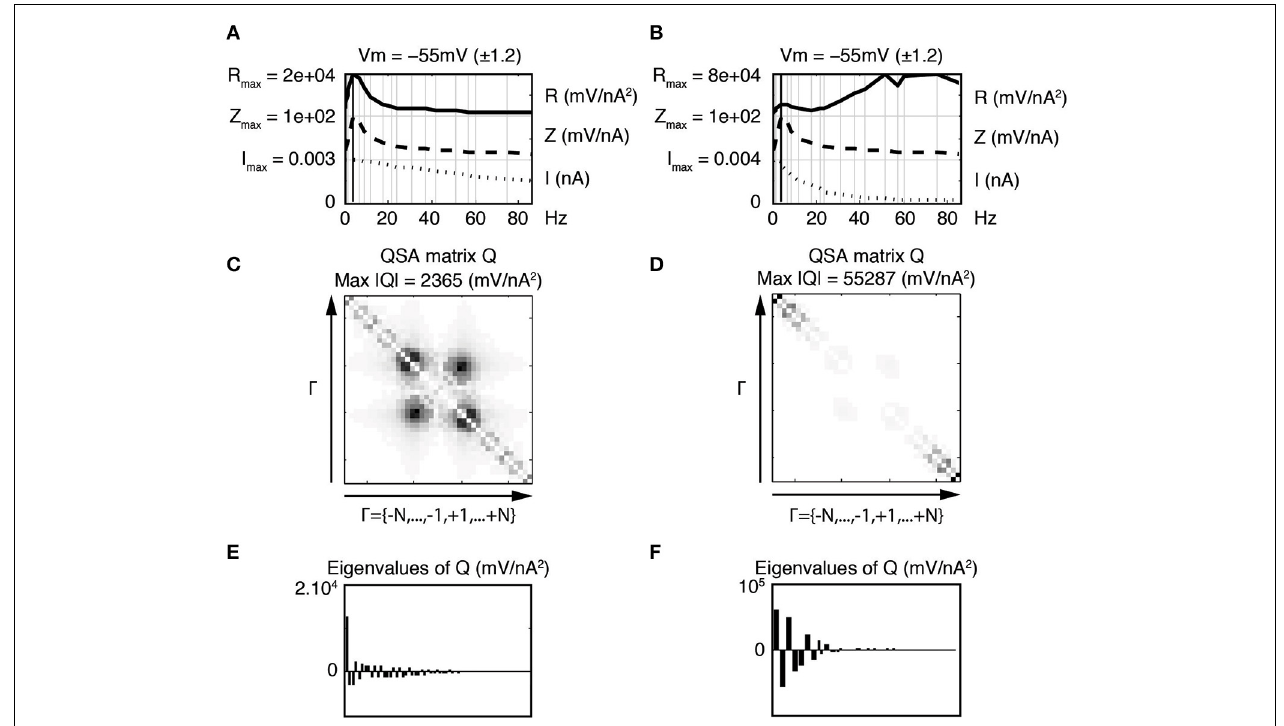
FIGURE 7 | Effect of stimulation profile on stellate neuronal model simulations. Left column (A,C,E) Weakly low pass filtered stimulation I in dotted lines. Right column (B,D,F) Strongly low pass filtered stimulation I in dotted lines. The resonance of the impedance ( Z ) is f 6 = 4 . 0Hz for both stimulations (A,B) . The attenuation of high frequencies in the stimulation of the second column induces enhanced quadratic responses as indicated by the R functions in the top row (A,B) as well as the QSA matrix (C,D) and eigenvalues (E,F) . The stimulation frequencies are the same as in Figure 4 . The parameter values (in units based on mV and nA) are as